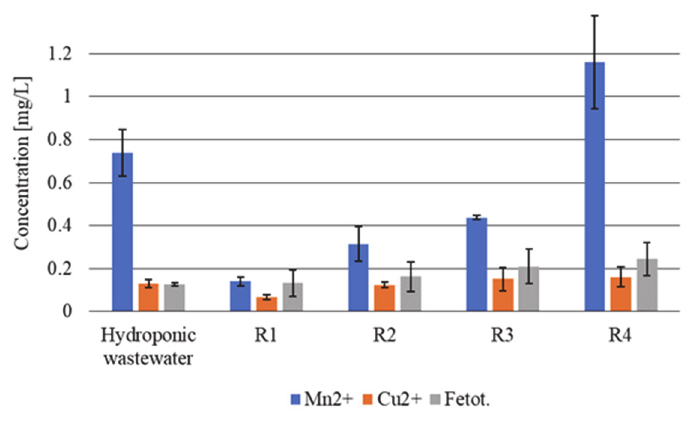
Figure 6. Concentration of Mn 2+ , Cu 2+ and Fe tot. in BER effluent. The aluminium concentration in R1 was outside the detectability range (<0.2 mg